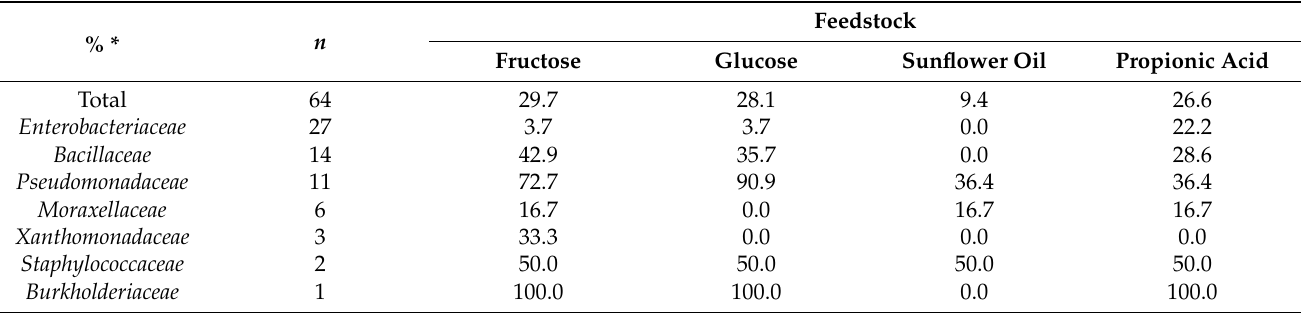
Table 3. Phenotypic detection of PHA production (%) from four different carbon sources (feedstock) in food isolates and collection strains from seven